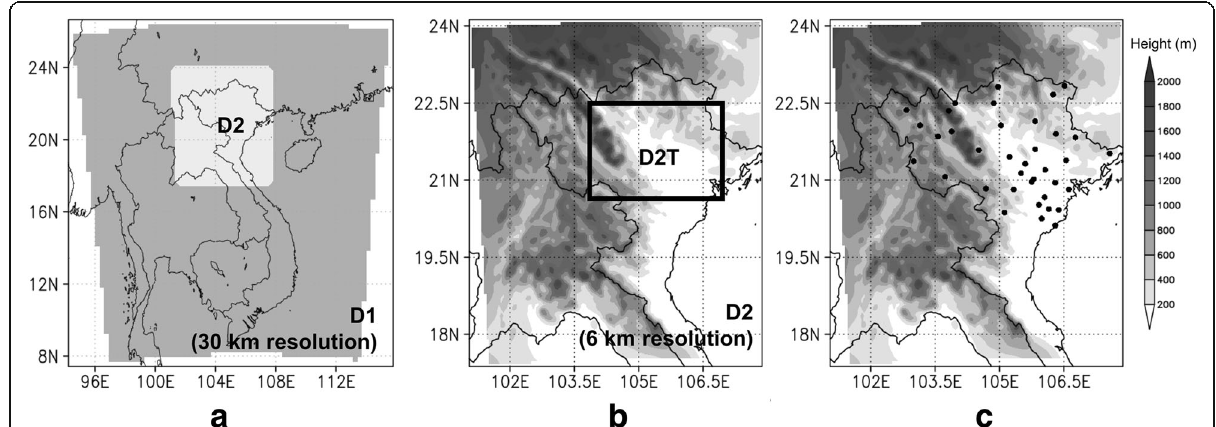
Fig. 1 Target areas for downscaling with WRF and ANN. a The outer (D1) and inner (D2) domains are indicated by gray shade and white, respectively. The spatial resolution was 30 km for D1 and 6 km for D2. b The target area for ANN downscaling (D2T) is indicated by a rectangle inside D2. c Geographical distribution of the 38 rain gauges providing data for this research are indicated by black dots